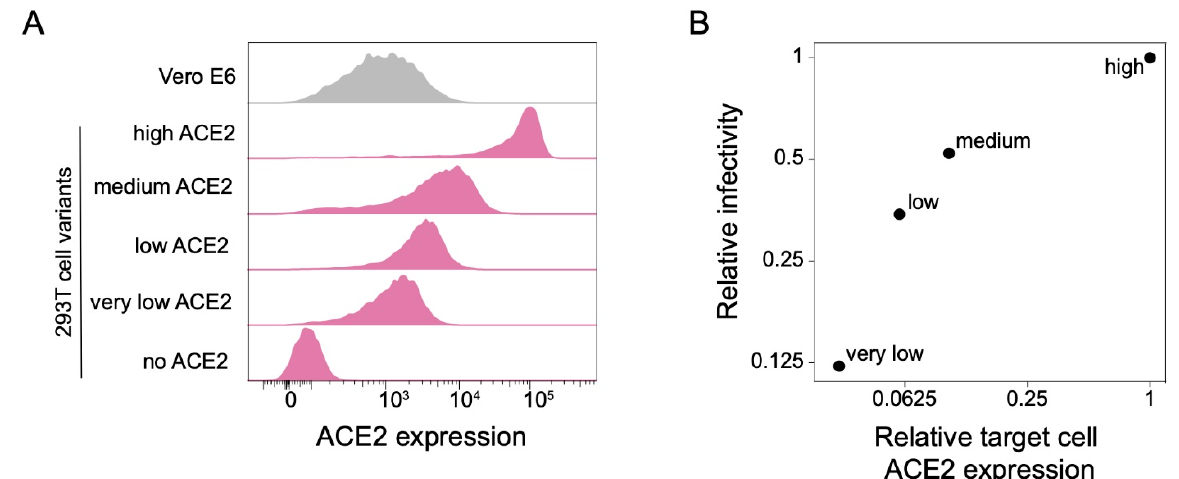
Figure 1. 293T cell clones expressing ACE2 at different levels. ( A ) ACE2 expression in 293T cells engineered to express different levels of ACE2. ACE2 surface expression was measured by flow cytometry, and the histograms show the distribution of expression levels over a population of cells. Vero E6 cells are included for comparison. ( B ) Relationship between ACE2 expression in the four 293T target cell clones and infection by lentiviral particles pseudotyped with the SARS-CoV-2 D614G spike.